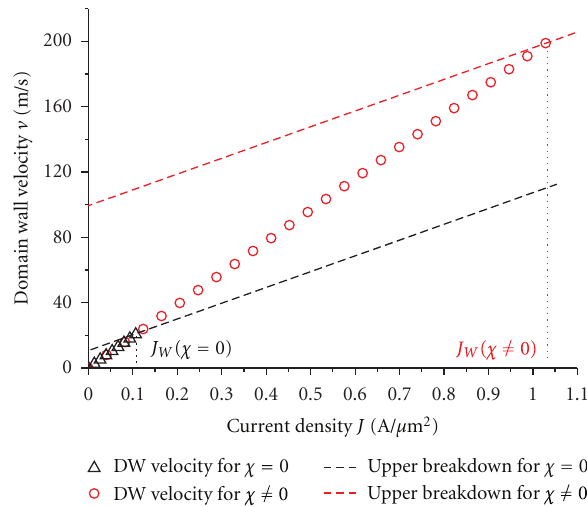
Figure 3: Current-driven DW velocity in the steady dynamic regime with and without Rashba field ( χ / = 0 and χ = 0, resp.) computed analytically by using (24) together with the upper breakdown condition (27).